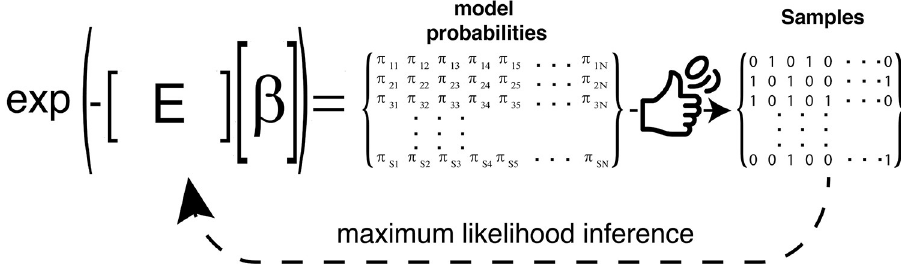
Fig 1. Schematic of the SigMoiD approach. Probabilities π si for binary variables i in samples s are generated according to a Gibbs-Boltzmann distribution with energies (features) E and inverse temperatures (latents) β . The observed data (samples) is assumed to have arisen from Bernoulli trials based on the model probabilities. SiGMoiD infers the parameters E and β using maximum likelihood